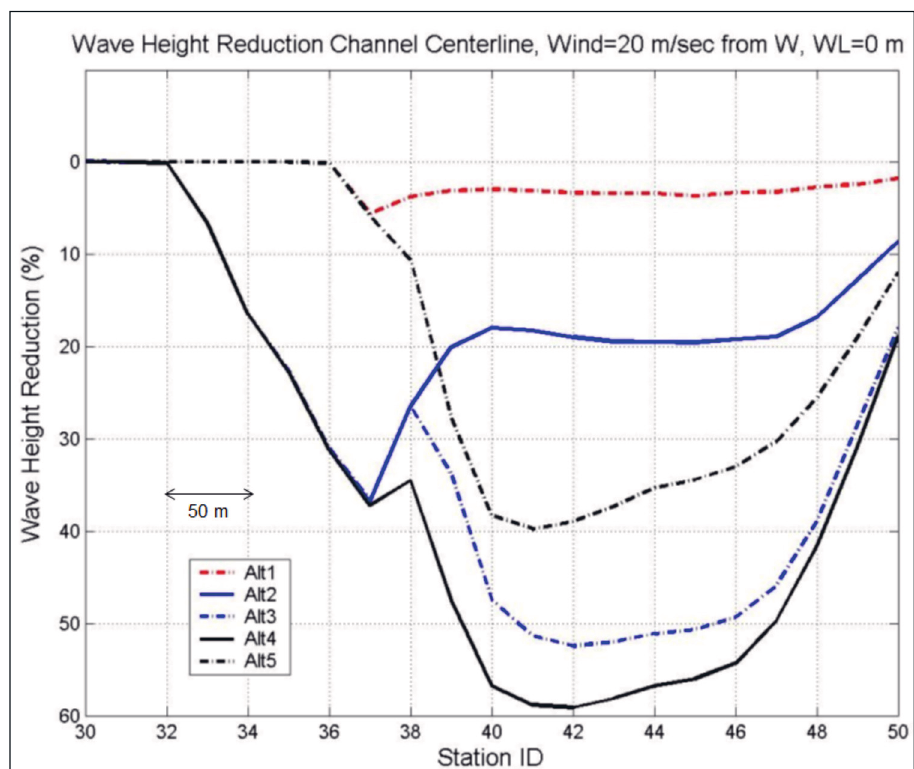
Figure 27. Calculated wave height reduction for Alts 1–5 along the west channel centerline for 50-year design wind from W and WL = 0 m.